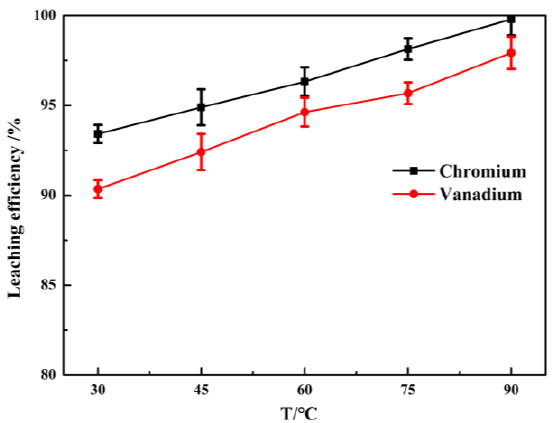
Figure 6. Effect of reaction temperature on the leaching efficiency of vanadium and chromium.